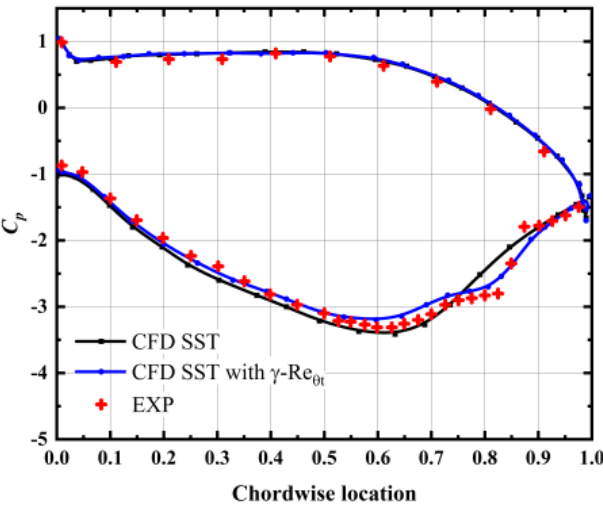
Figure 7. Comparison of different numerical methods and experimental results at Re = 10 5 .